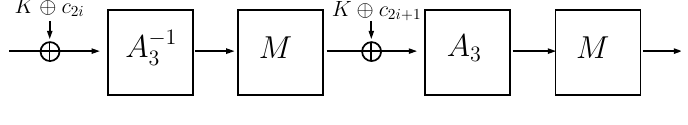
Figure 5: The step function number i